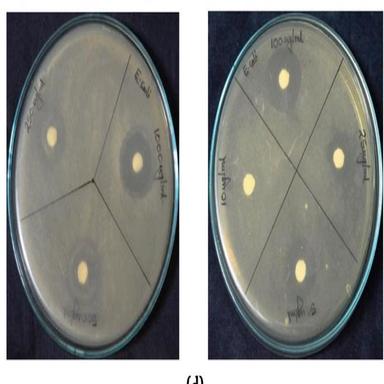
Zone of inhibition against E. Coli by (a) Standard streptomycin (b) DMPI and (c) IC-1(Inclusion complex of HP-β-CyD and DMPI) (d) E. coli standard.